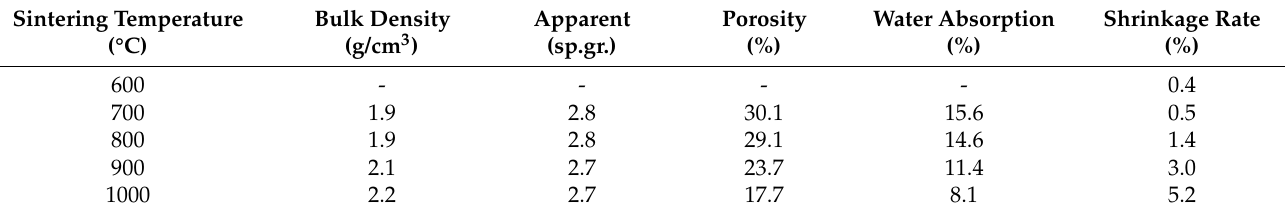
Table 2. Physical properties of building bricks made with drill